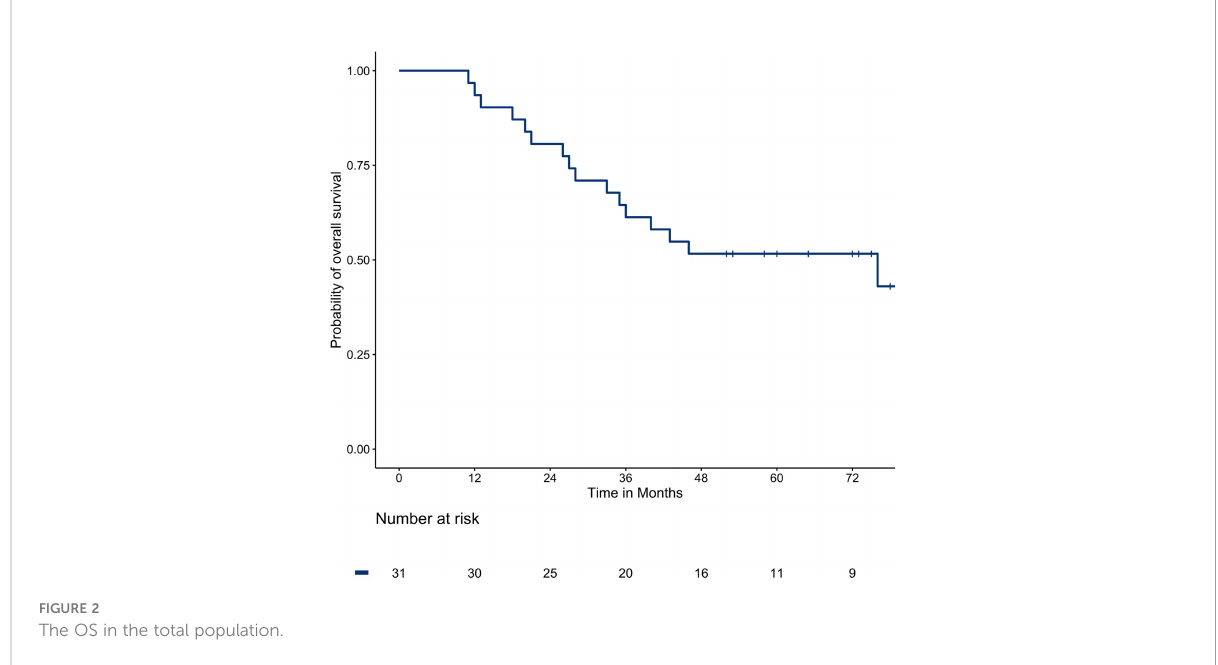
FIGURE 2 The OS in the total population.